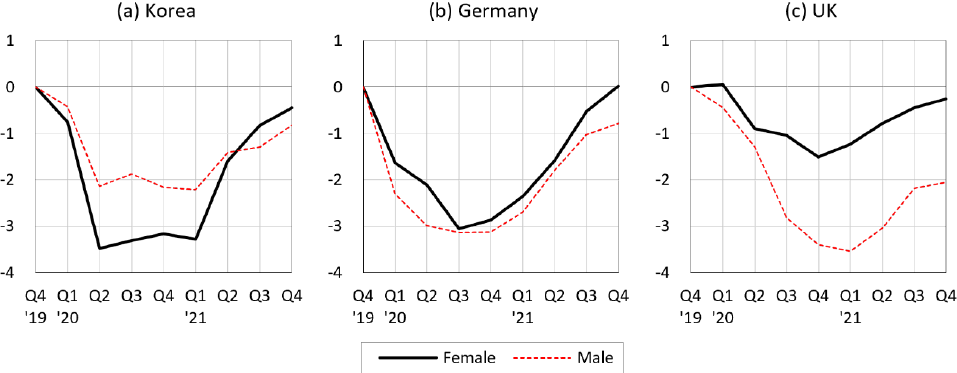
Figure 3. Percent change in employment by gender during the quarters of the first two years of the COVID-19 pandemic compared to 2019 Q4: a comparison between South Korea, Germany, and the UK. Notes: Workers aged 15–64, seasonally adjusted, data from OECD.Stat, available online: https://stats.oecd.org (accessed on 15 November